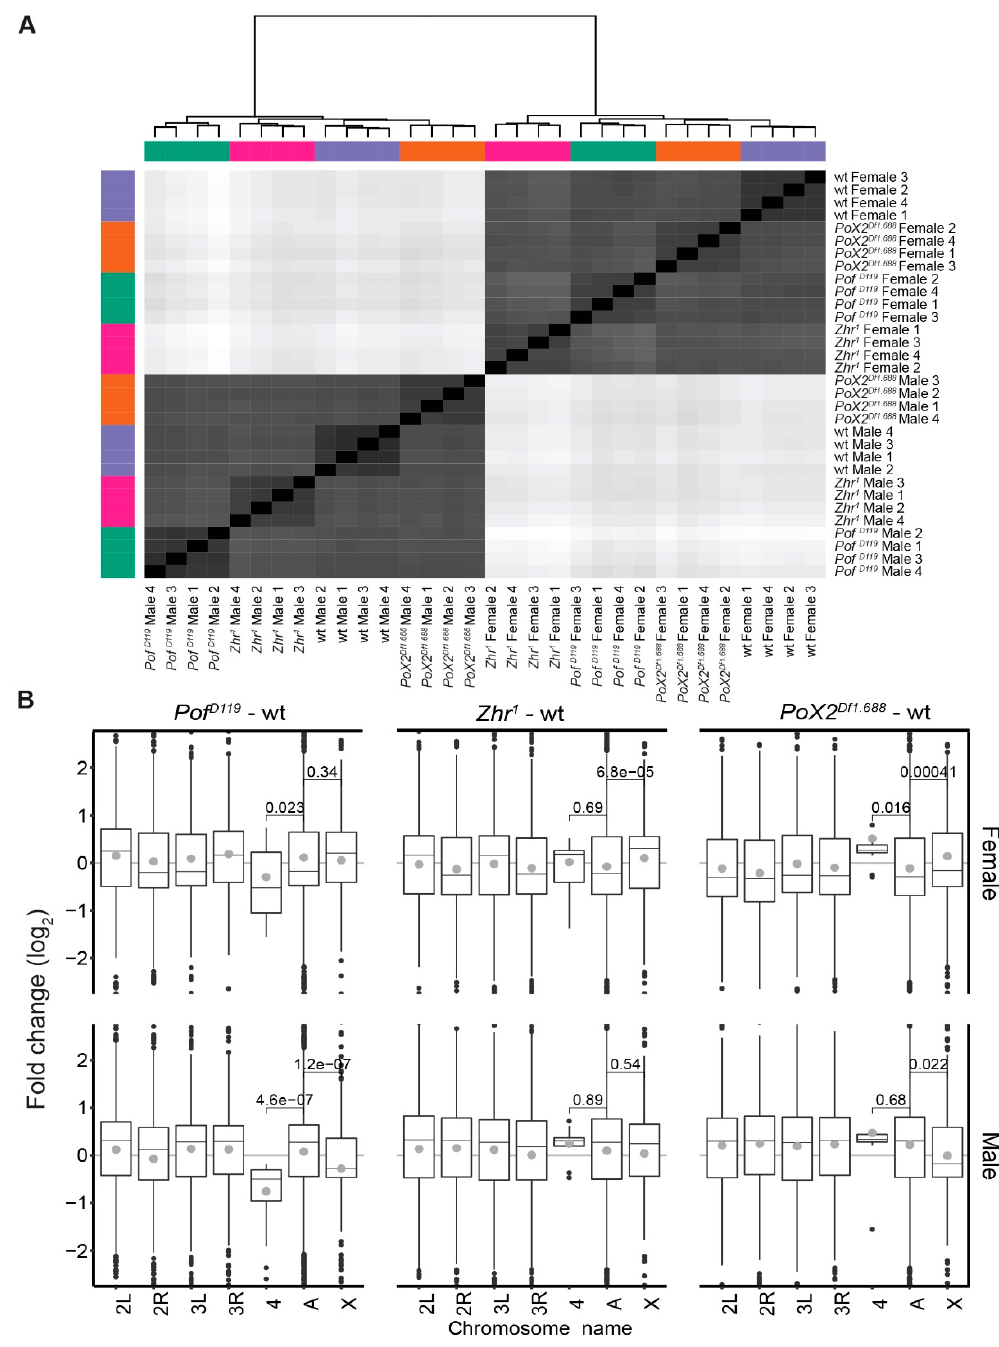
Figure 1. The gender-dependent genome differential analysis shows chromosome-specific alterations within genotypes versus wild type. ( A ) Samples were clustered and depicted in a heatmap based on Euclidian distances of gene read count RLT (regularised logarithm transformation). Sex is the major sample separator, followed by genotype. ( B ) Box plots representing expression ratios of whole transcripts (except satellites and transposable elements) for individual chromosome arms and chromosomes 2 and 3 combined (indicated A) in each mutant versus wild type. The box plots display median (line), average (dot), first and third quartiles (box), highest/lowest values within 1.5 × interquartile range (whiskers), and outliers. The statistical significance was determined by the Wilcoxon signed-rank test and p-values are indicated.